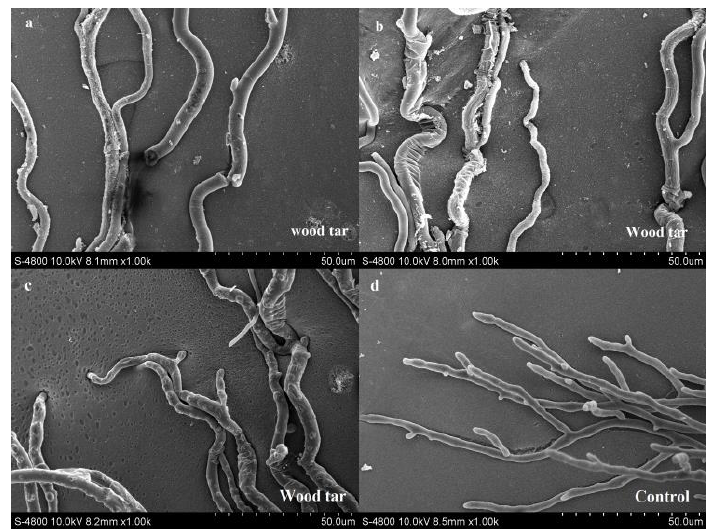
Figure 1. Effect of wood tar on the mycelial morphology of V. mali : ( a – c ) plates treated with EC 50 concentration; ( d ): untreated plates.